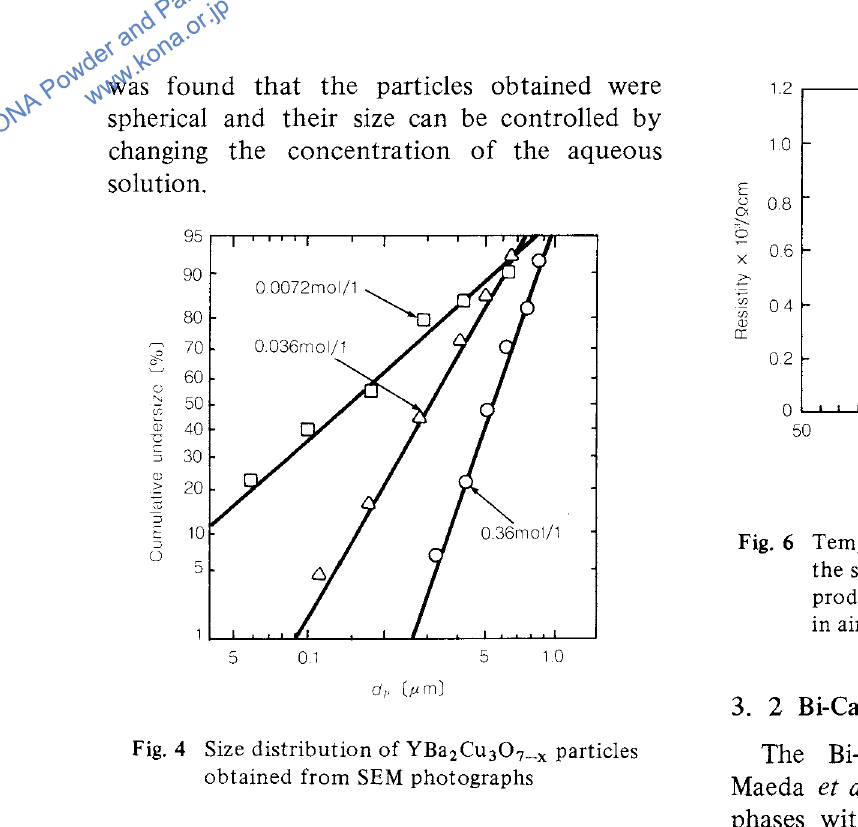
Fig. 4 Size distribution of YBa2 Cu307-x particles obtained from SEM photographs